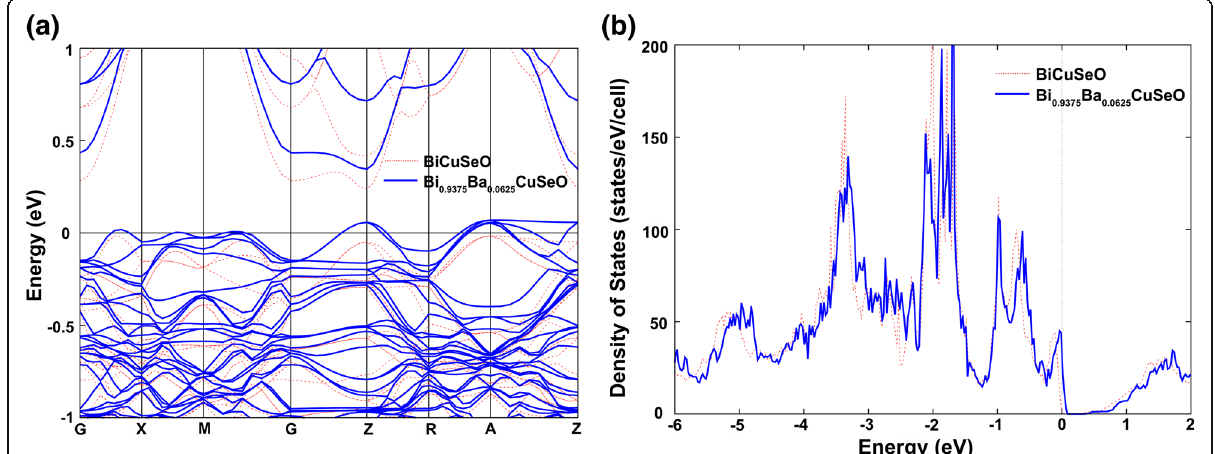
Fig. 5 a Band structure. b Density of states of the pristine and Ba-doped